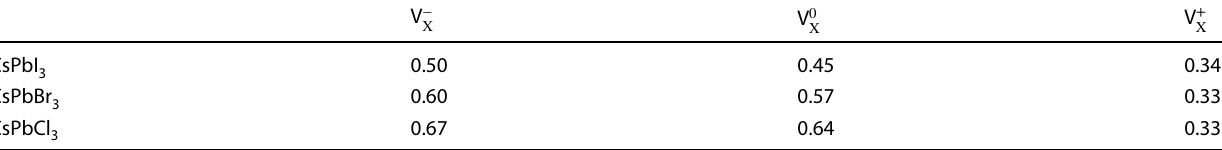
Table 1 Energy barrier (eV) associated with vacancy migration in cubic CsPbX the most stable (+) charge